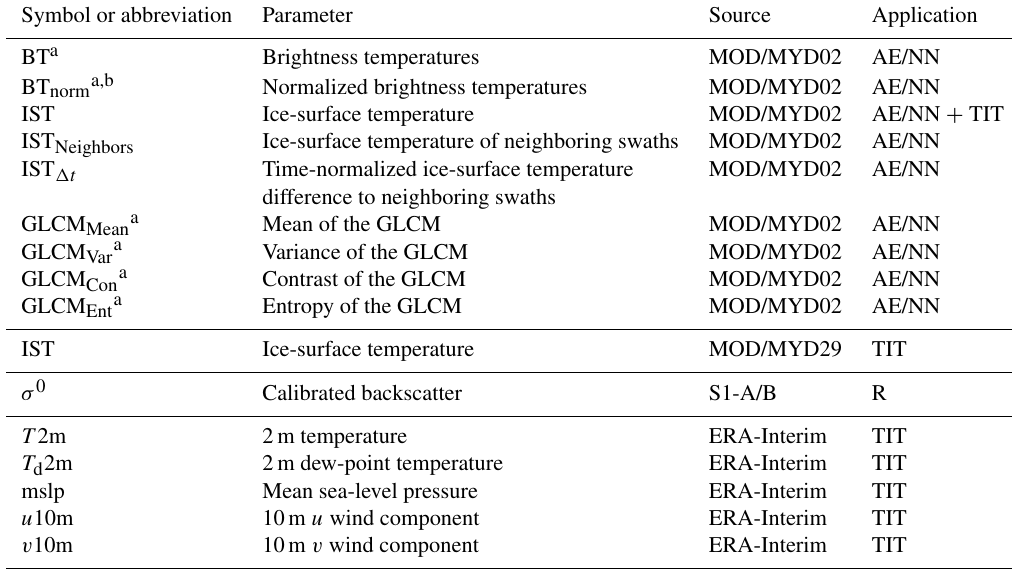
Table 1. Summary of all used parameters, their source product or sensor, and their application in this study. These parameters comprise the brightness temperature (BT) from the selected MOD/MYD02 channel subset a as well as normalized BT (BT normb ). Furthermore, ice-surface temperatures (IST) from MOD/MYD02 are presented together with the IST from neighboring swaths (IST Neighbors ) and the time-normalized IST change (IST (cid:49)t ) between them as well as the IST from the MOD/MYD29 product. The texture metrics calculated from GLCM (mean, variance, contrast, and entropy) as well as the calibrated backscatter ( σ 0 ) from Sentinel-1 A/B are given as a reference (R). Finally, the atmospheric parameters taken from the ERA-Interim reanalysis necessary for the calculation of thin-ice thickness (TIT) are presented. The applications comprise primarily their use in the training of the neural network (NN) and autoencoder (AE). Symbol or abbreviation Parameter